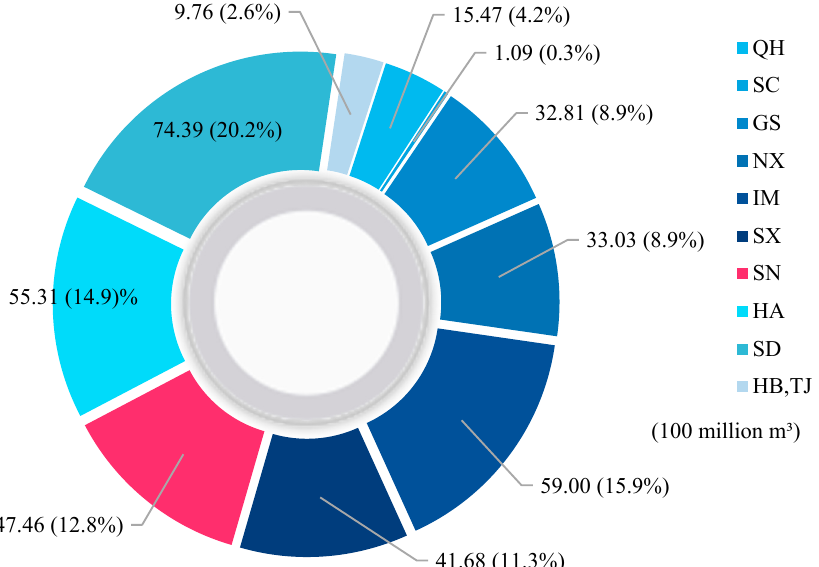
Figure 7. Results of the Yellow River water distribution scheme with 37 billion m 3 of water.